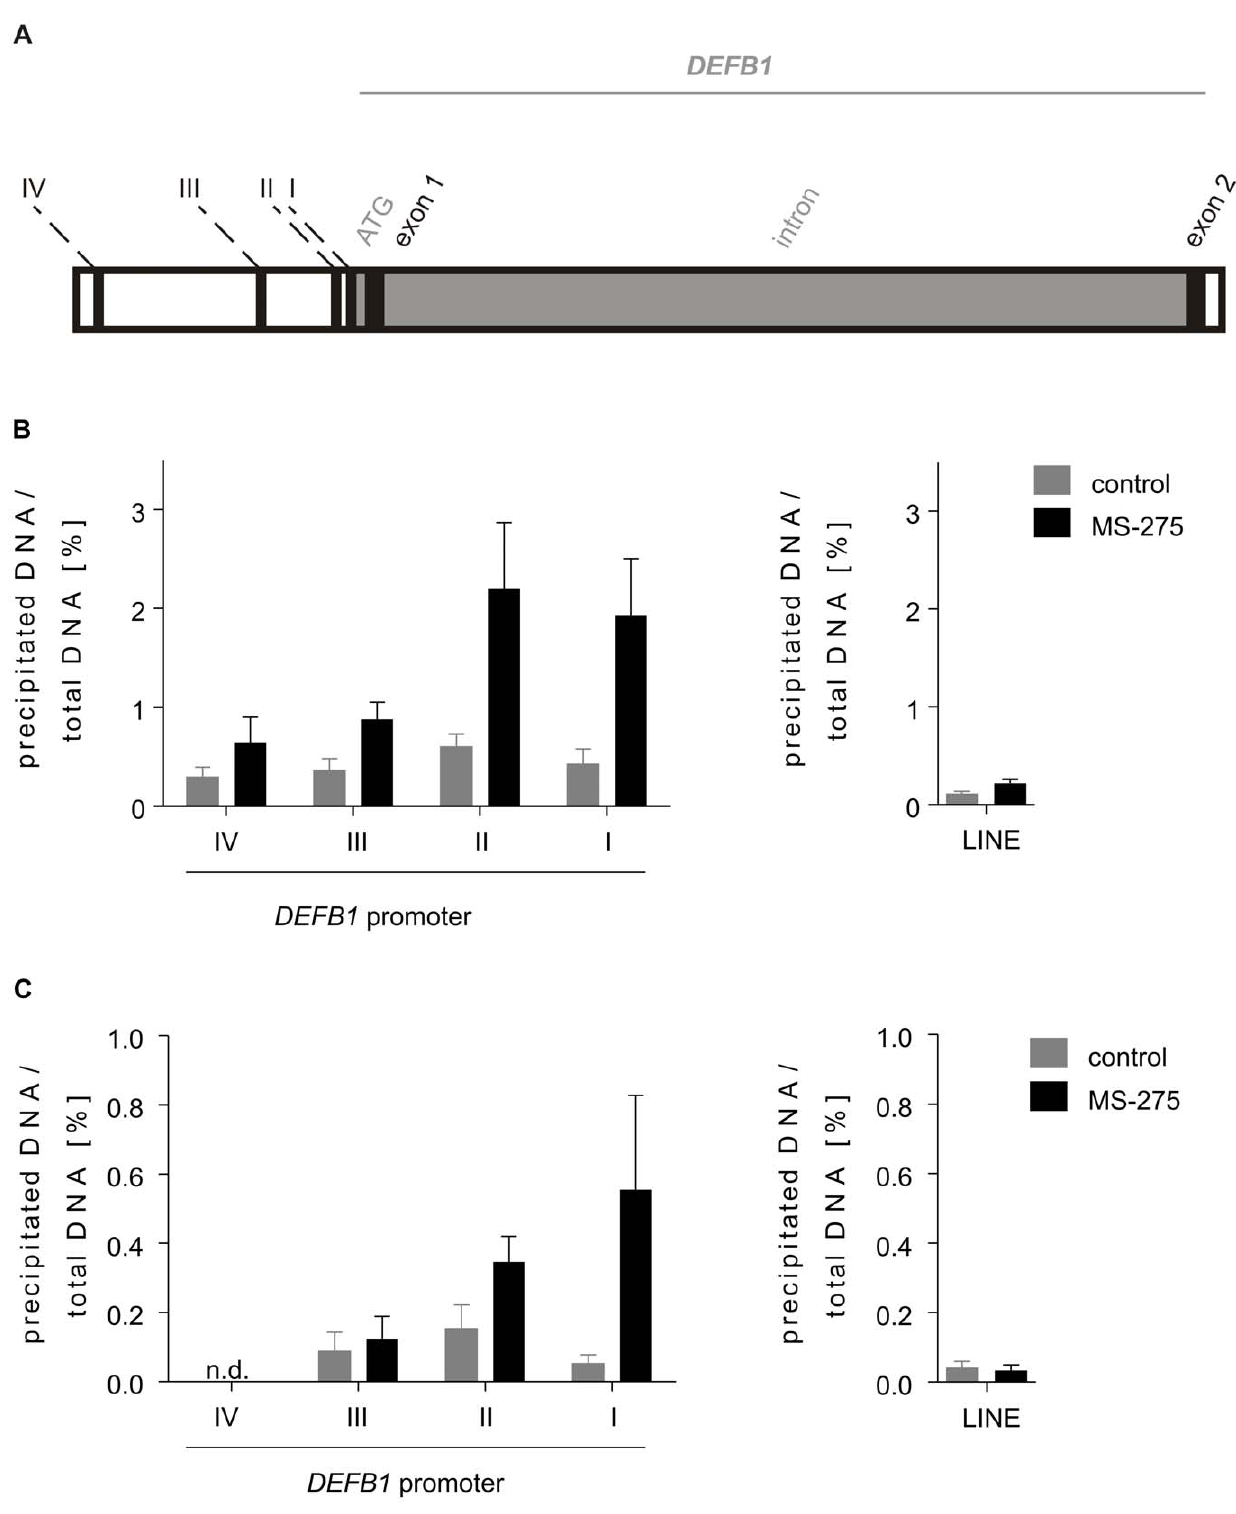
Figure 3. The HDAC inhibitor MS-275 increases H3 acetylation and H3K4 trimethylation at the DEFB1 promoter. (A) DEFB1 gene with promoter region including analysis sites I-IV. I: 2 186 – 2 250, II: 2 347 – 2 406, III: 2 1002 – 2 1061, IV: 2 2436 – 2 2499. (B–C) A549 cells were treated with HDAC inhibitor MS-275 for 36 h. ChIP analysis was performed using anti-acetyl-Histone H3 (B) and anti-trimethyl-H3K4 (C) antibodies. Isolated DNA was quantified using quantitative RT-PCR. Bars represent means with SEM of three independent experiments. LINE: long interspersed nuclear element.